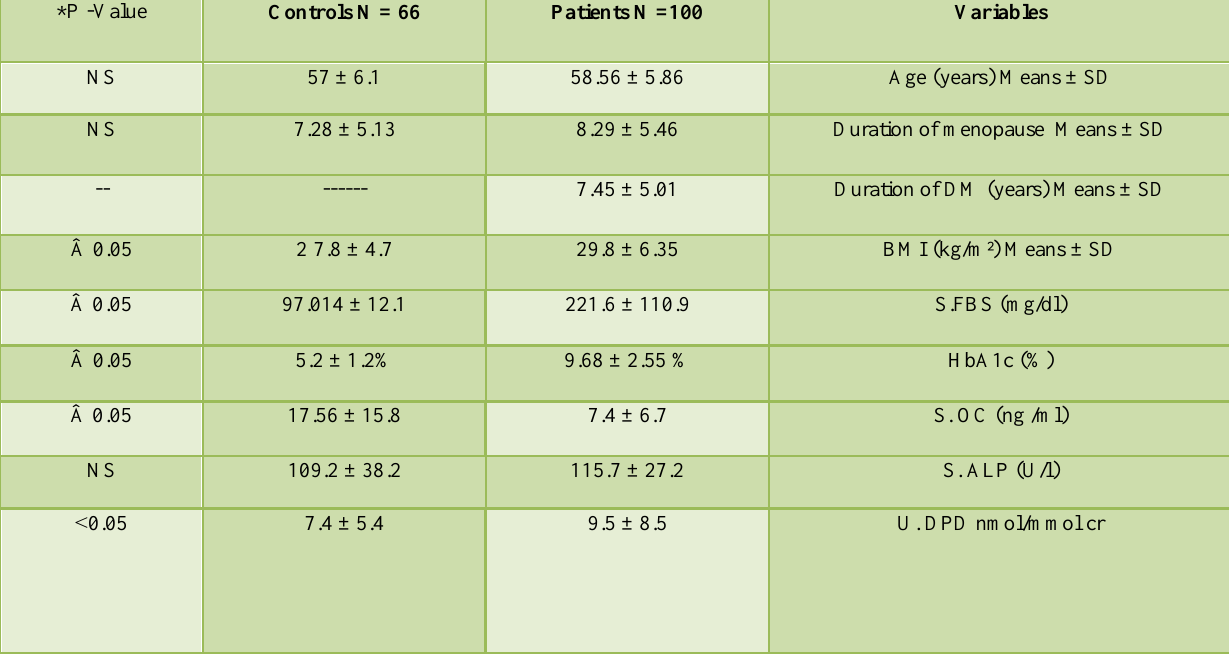
Table-1.1-The baseline characteristics and biochemical parameters for both diabetes patients and